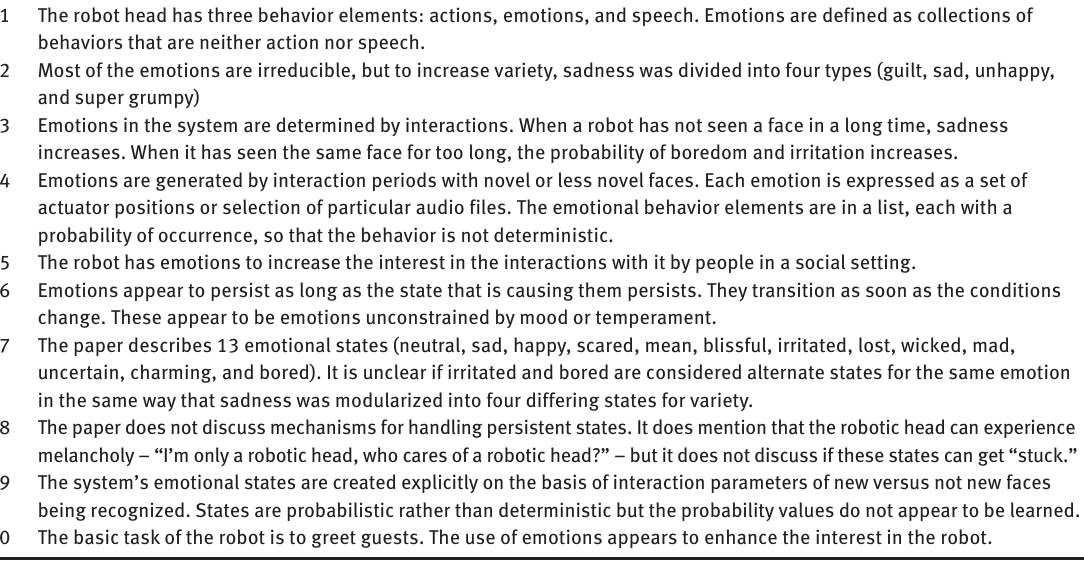
Table 5. Classification of Samuel